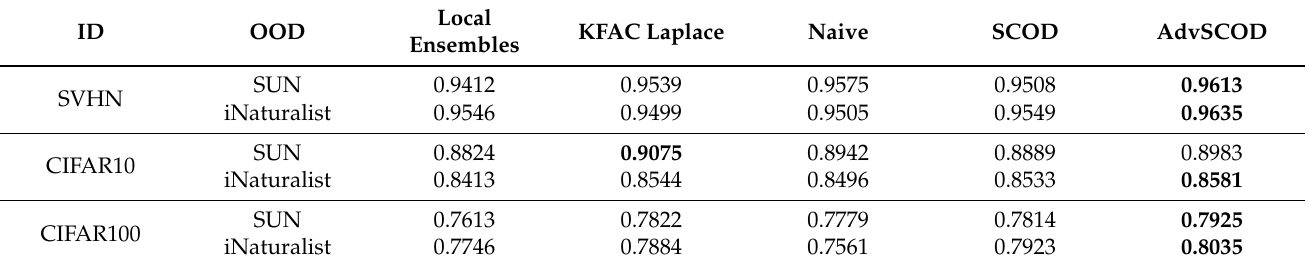
Table 7. Comparison of the OOD detection performance using large-scale datasets. Bold numbers are superior results.